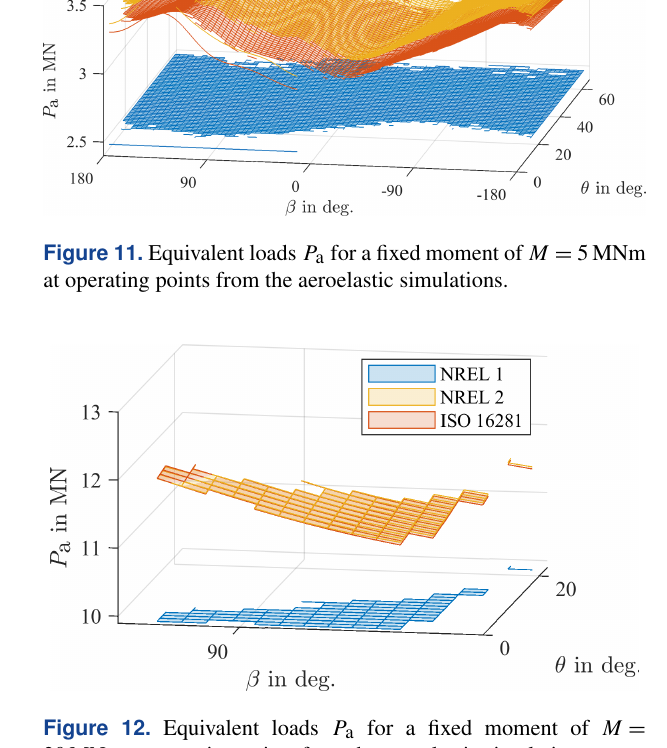
Figure 12. Equivalent loads P a for a fixed moment of M = 20MNm at operating points from the aeroelastic